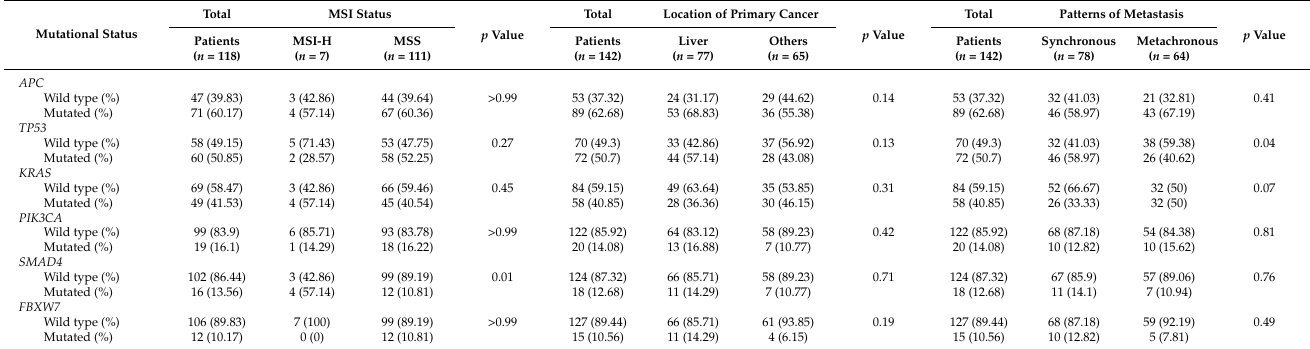
Figure 3. Landscape of mutations in 99 primary and 142 metastatic groups (including 95 pairs of primary and metastatic tumors). Each column represents a single patient. The percentage of mutations across each group is represented by vertical histograms. Table 3. Association between mutational status and clinicopathological features.